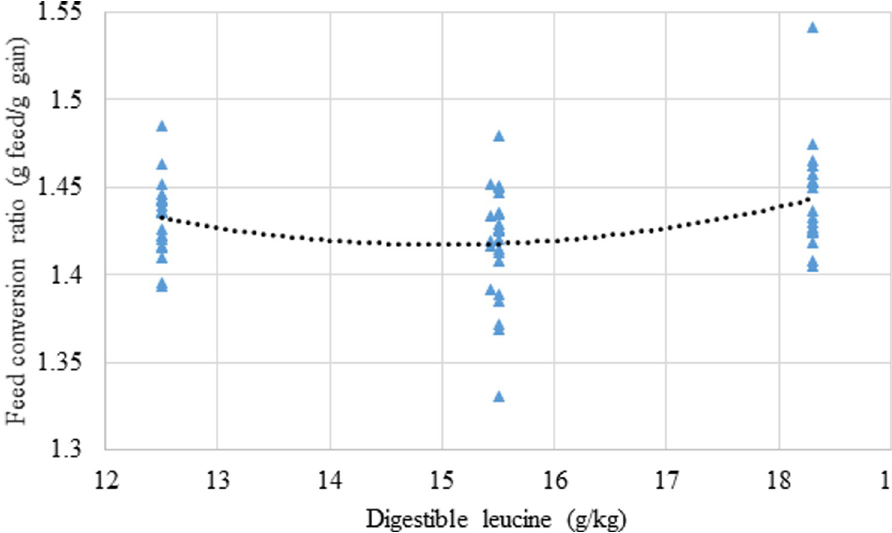
Fig 2. Quadratic relationship (P = 0.014; r = 0.358) between dietary leucine concentrations and FCR from 7 to 28 days post-hatch where: FCR (g/g, 7-28d) = 1.956 – 0.0719 × digestible leucine (g/kg) + 0.0024 × digestible leucine (g/kg)2 . A dietary leucine concentration of 14.99 g/kg corresponds to the minimum FCR of 1.418 (g/g).